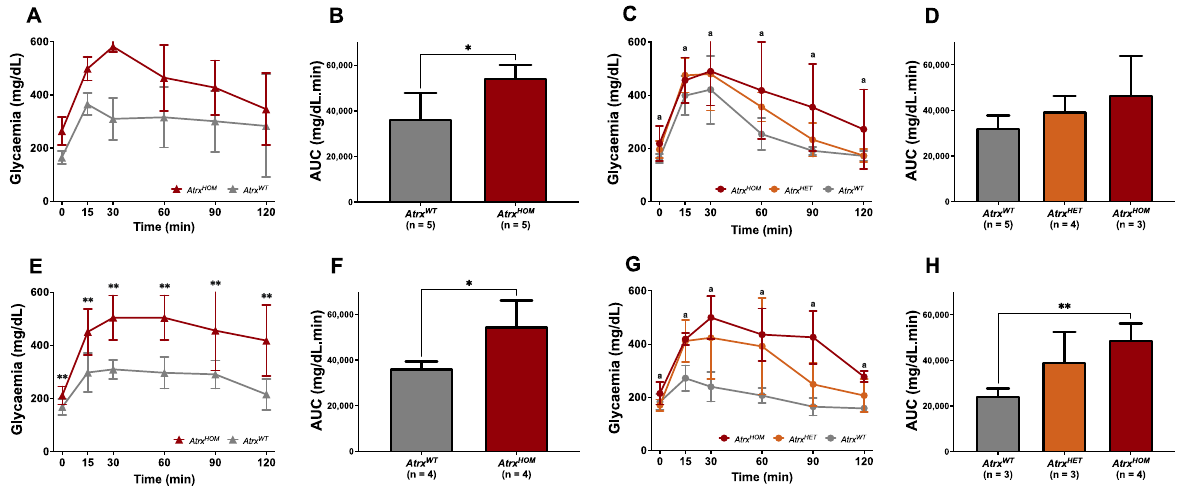
Figure 5. Evidence of glucose intolerance. Intraperitoneal glucose tolerance tests (ipGTTs) indicate that, by 6 mo., Atrx HOM have significantly increased glucose intolerance ( A , B ), while females show a similar tendency ( C , D ); by 12 mo., both male ( E , F ) and female ( G , H ) Atrx HOM mice exhibit significant frank deterioration of glucose tolerance; Atrx HET females, who are the heaviest, are not the ones with higher glycaemic values (see Figure 4C,D), responding better to ipGTT than Atrx HOM females; two-way ANOVA used for comparisons in each time point: a p < 0.01 ( Atrx HOM vs. Atrx WT ) ( C , G ). * p < 0.05, ** p < 0.01.